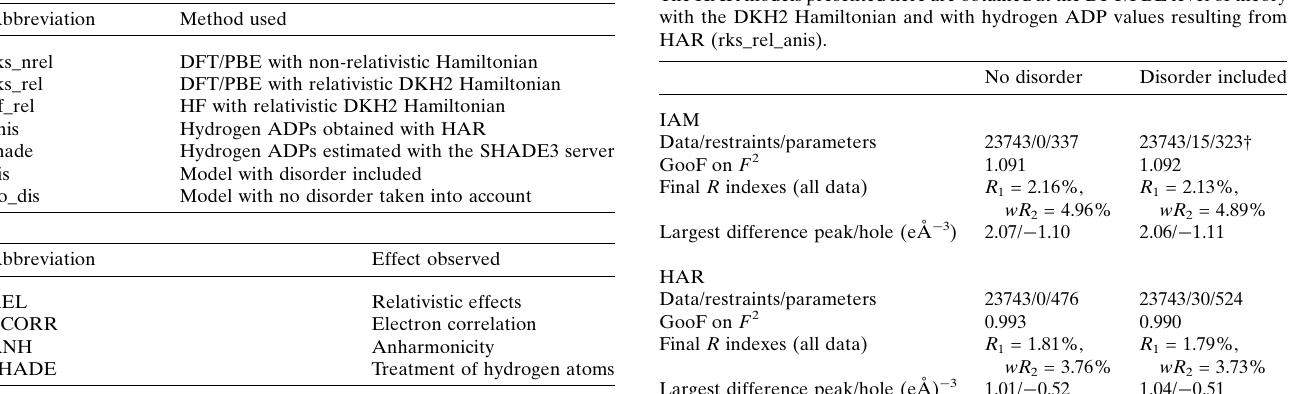
Table 1 Abbreviations used in this study to describe all possible HARs and effects observed.